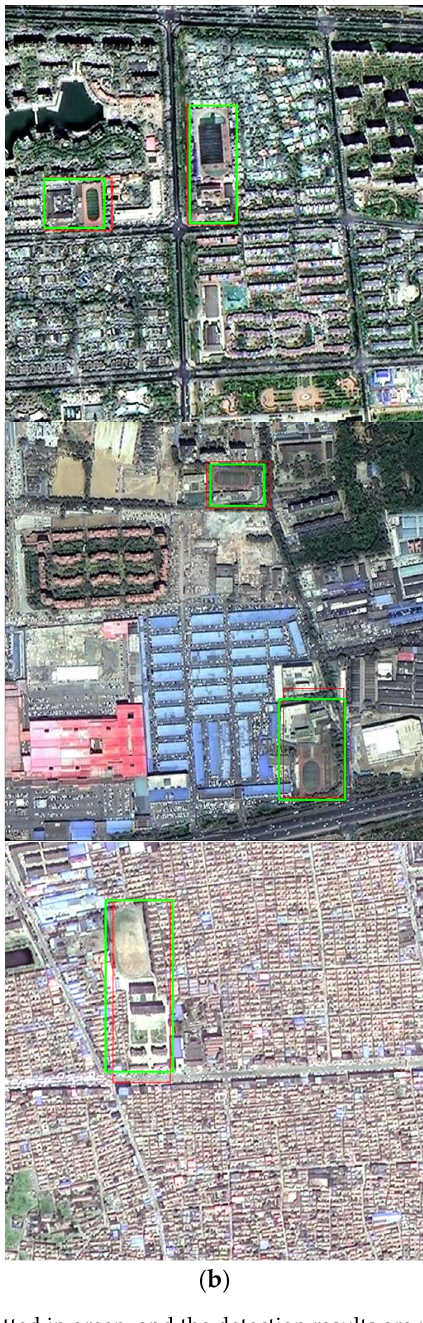
Figure 9. Detection results on the test set. The ground-truth boxes are plotted in green, and the detection results are plotted in red: ( a ) the detection results of Faster R-CNN; ( b ) the detection results of ADNet.